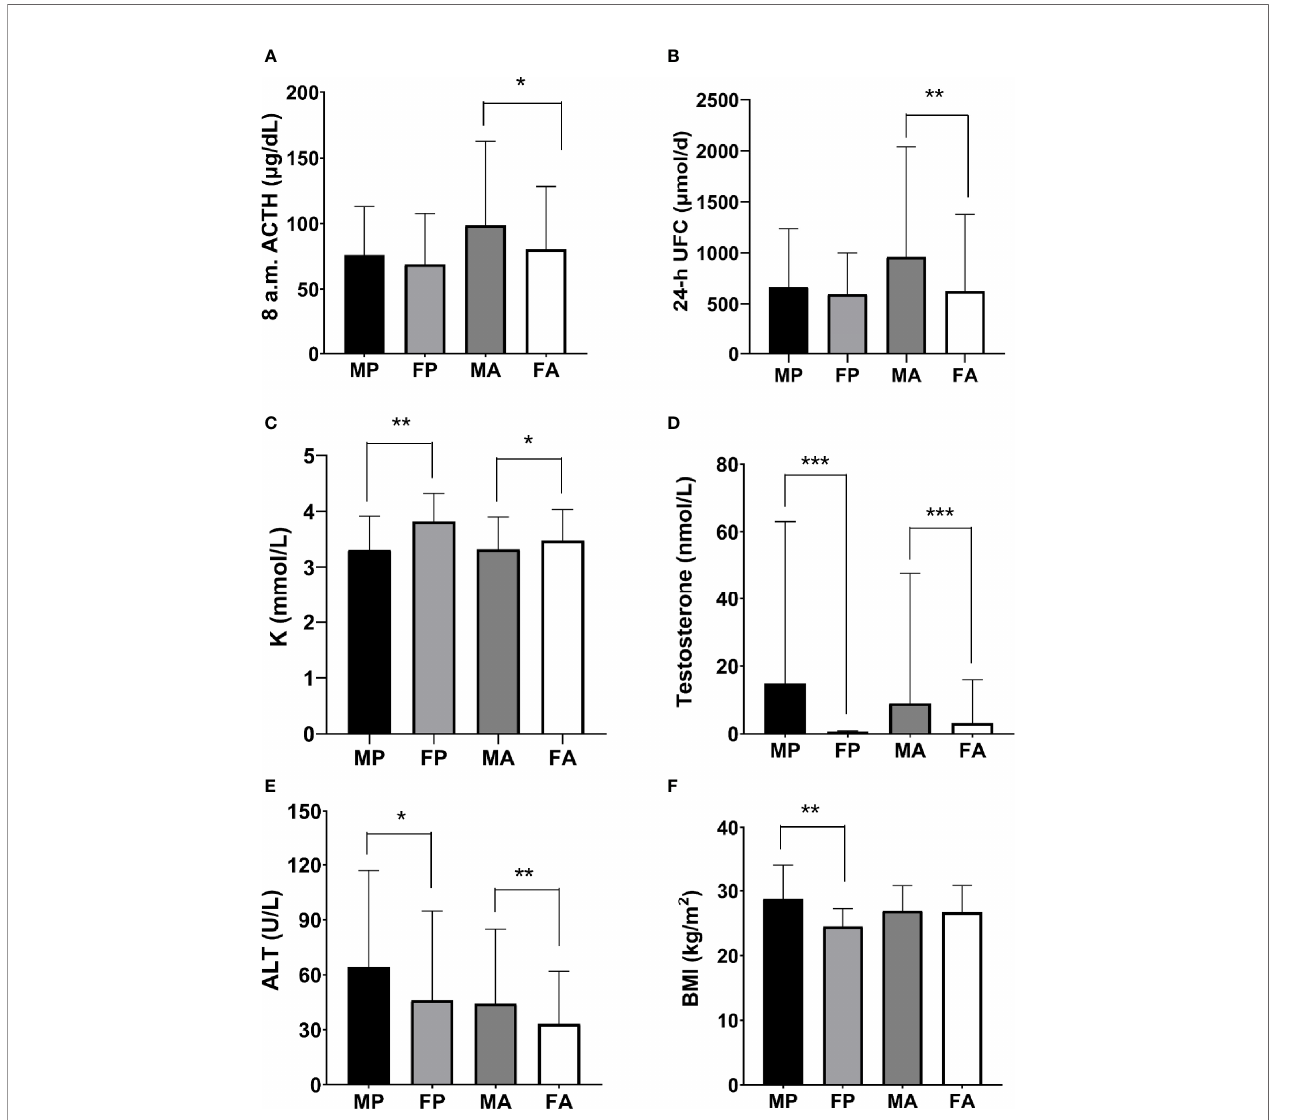
FIGURE 4 | Gender-related laboratory investigation tests in pediatric and adult-onset CD. The parameters of PA activity, (A) 8 a.m. ACTH, and (B) 24-h UFC, were signi fi cantly higher for adult male patients. The levels of (C) serum potassium, (D) testosterone, and (E) ALT were also signi fi cantly higher for males in both pediatric and adult patients. (F) BMI was signi fi cantly higher for male patients in children. MP, male pediatric patients; FP, female pediatric patients; MA, male adult patients; FA, female adult patients. (* P < 0.05, ** P < 0.01, *** P <